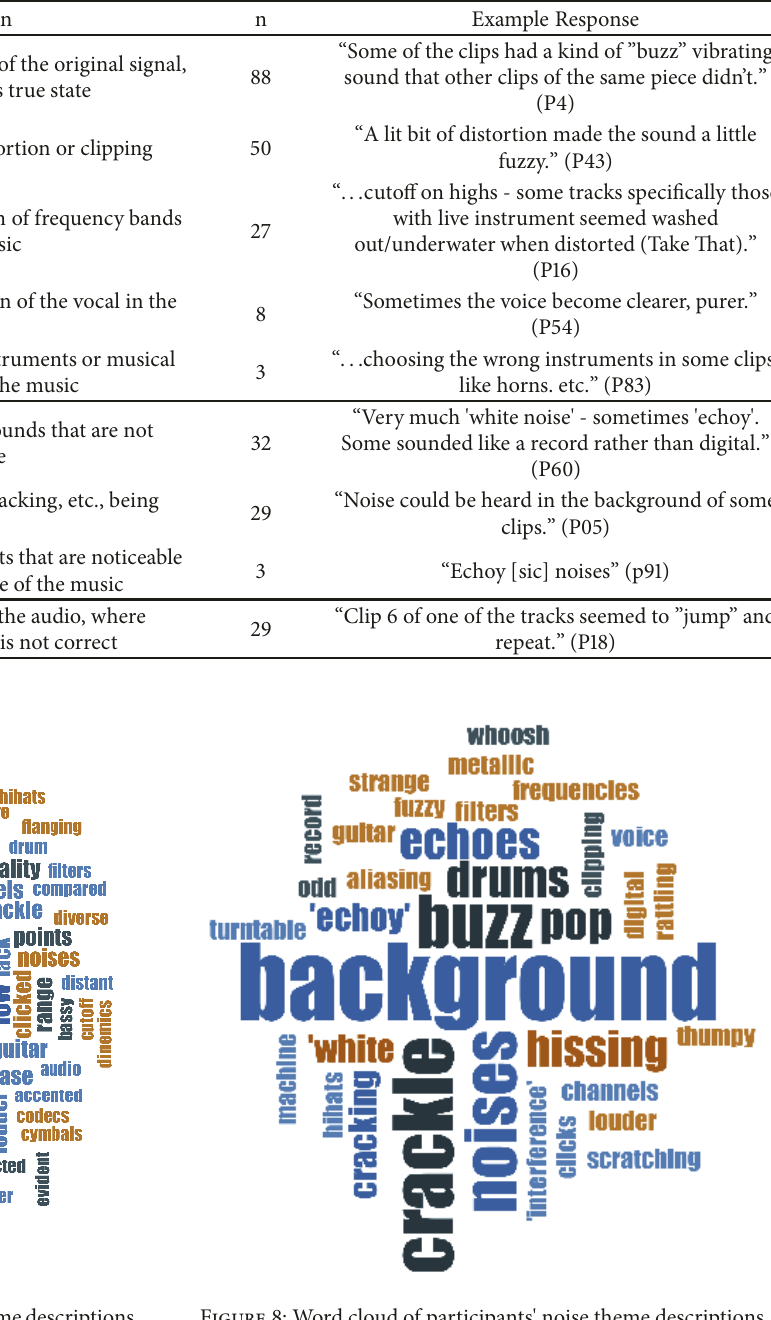
Figure 7:Word cloudofparticipants' distortionthemedescriptions. Figure 8: Word cloud of participants' noise theme